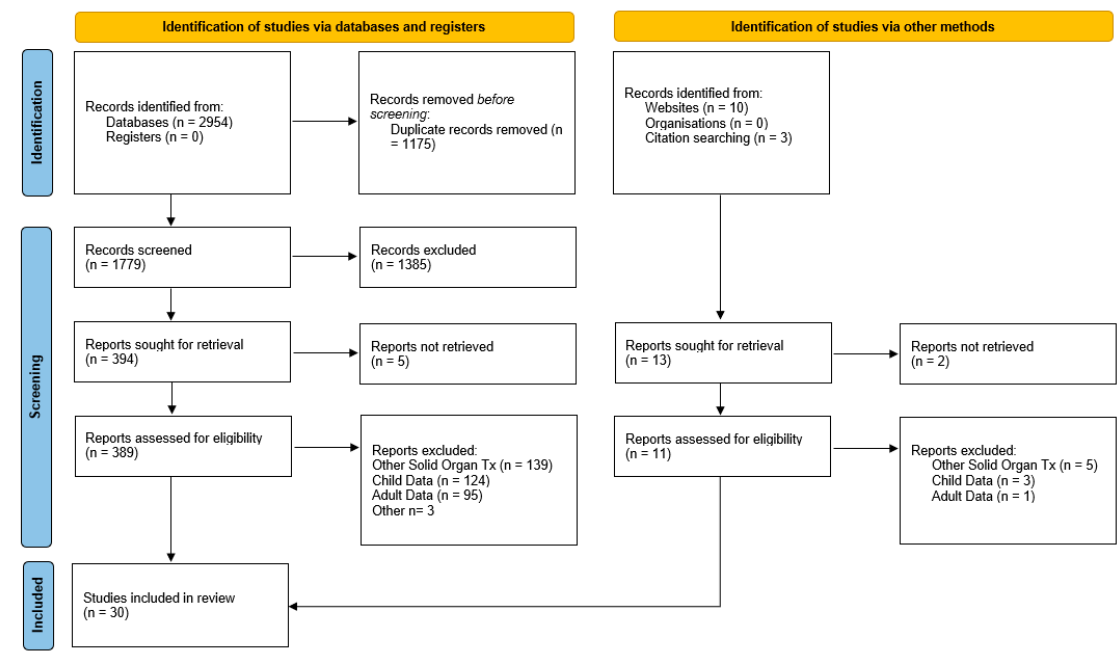
Figure 1. PRISMA 2020 Flow Chart.